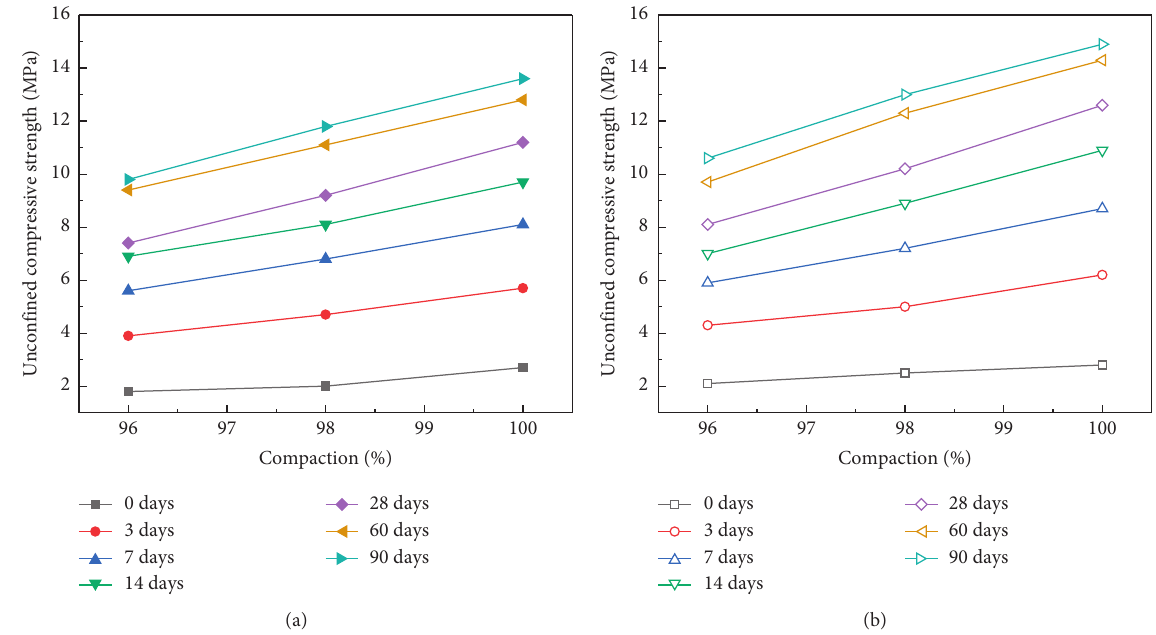
Figure 10: Effect of compaction degree on unconfined compressive strength. (a) GM gradation; (b) XM gradation.